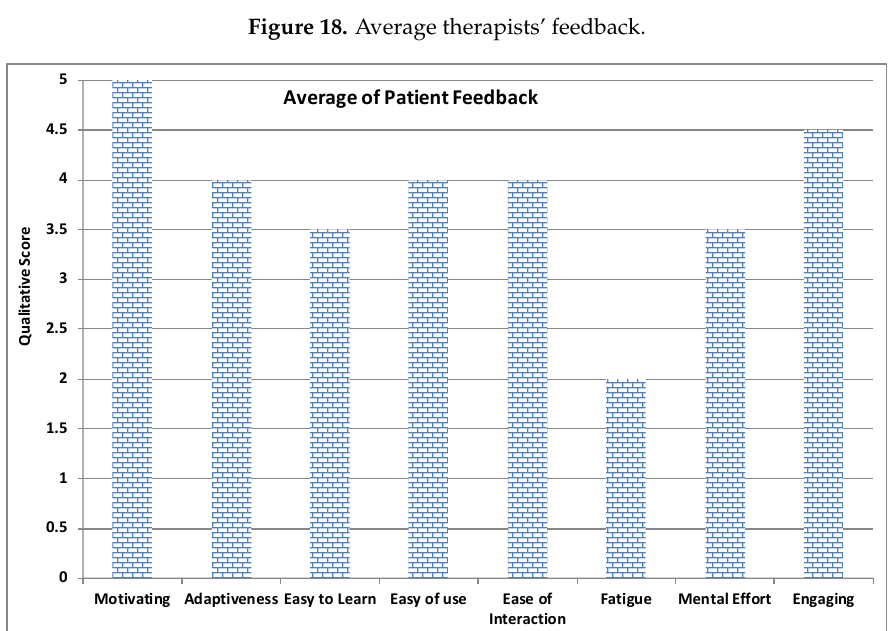
Figure 19. Average of patient